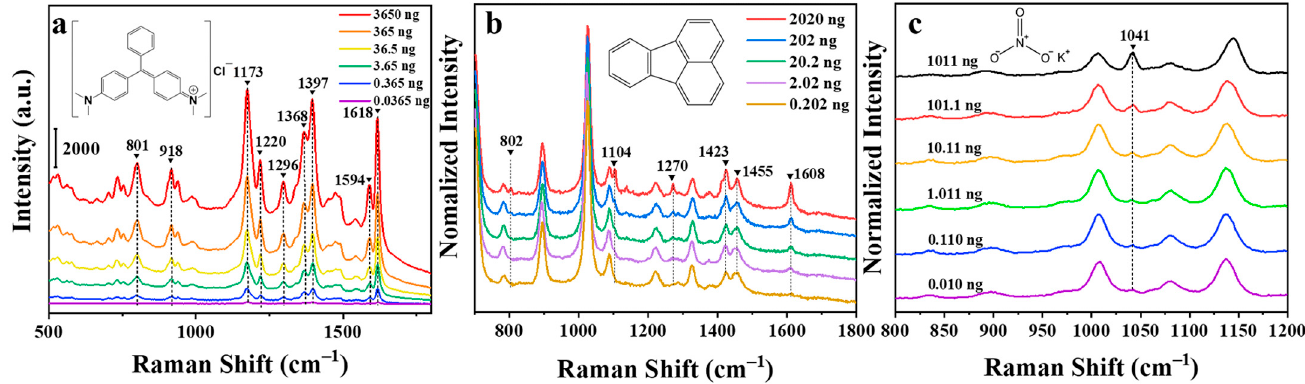
Figure 7. SERS spectra of malachite green ( a ), fluoranthene ( b ), and potassium nitrate ( c ) on silver nanowire membranes treated by 15 CV cycles at 20 °C.